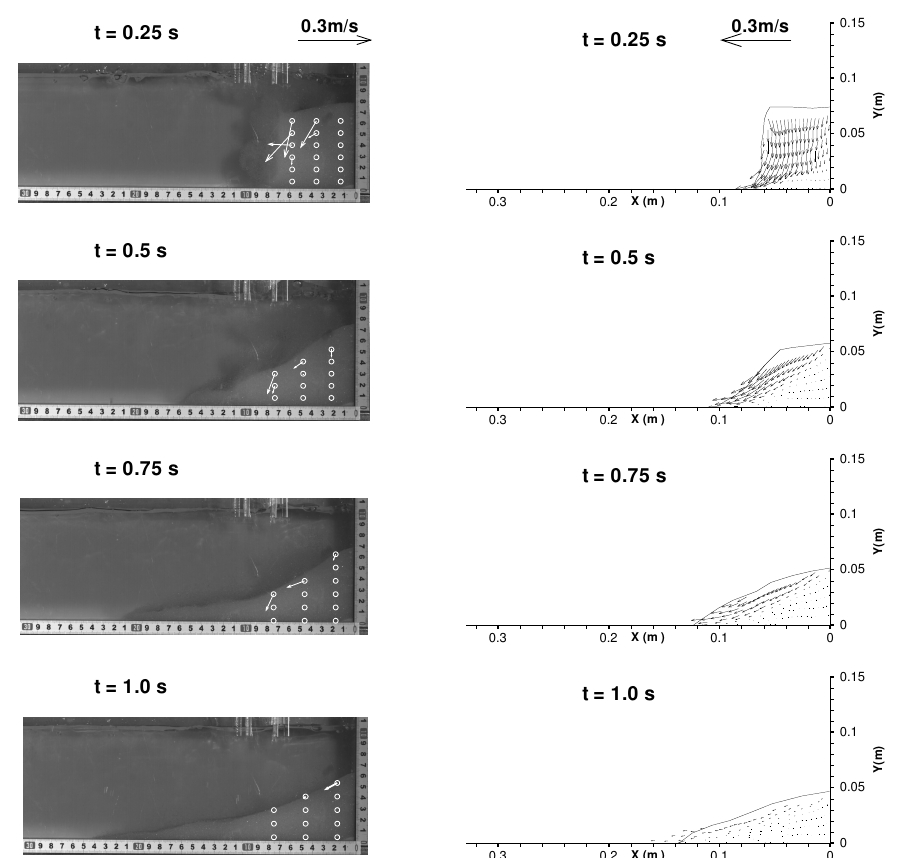
Figure 14. Granular velocity field at some representative times for an initially loose packing column collapse. Left column: experimental observations; Right column: numerical simulations.